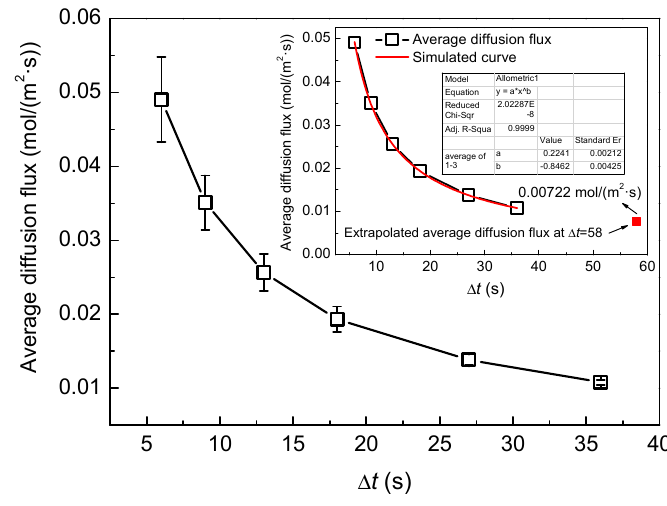
Figure 12. The average diffusion flux of iron atoms at different time variables.